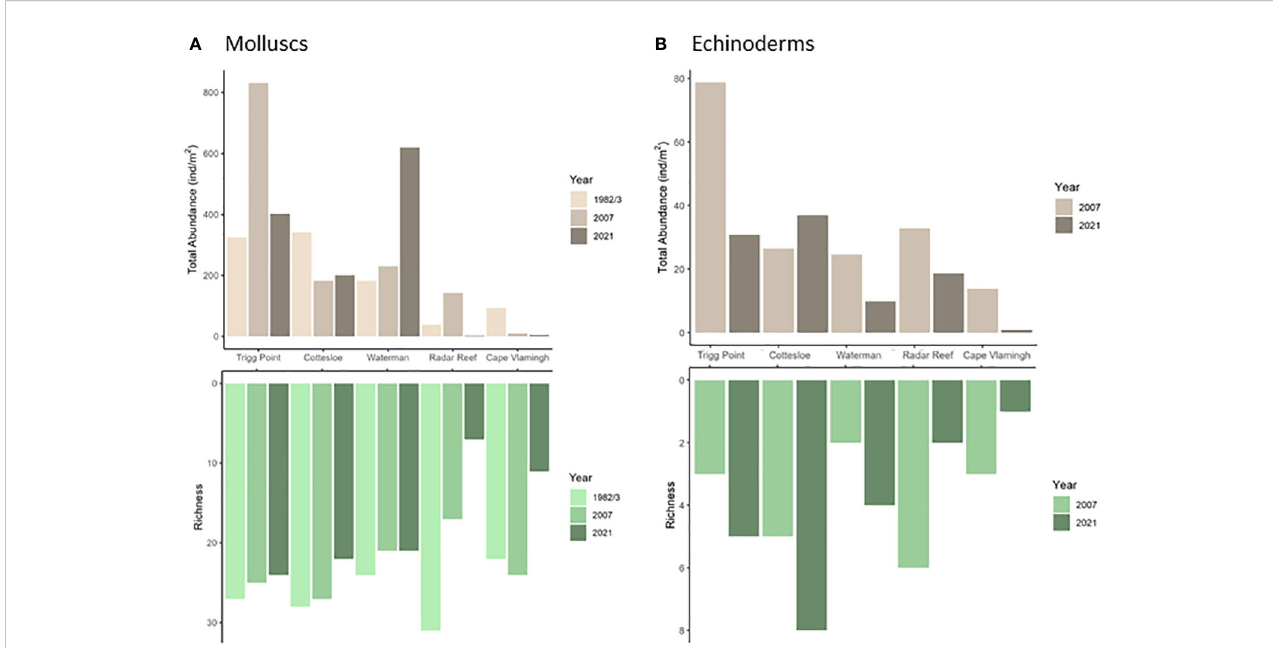
FIGURE 2 Density and diversity (as richness) of platform molluscs (A) and echinoderms (B) at fi ve sites in 1982/3, 2007 and